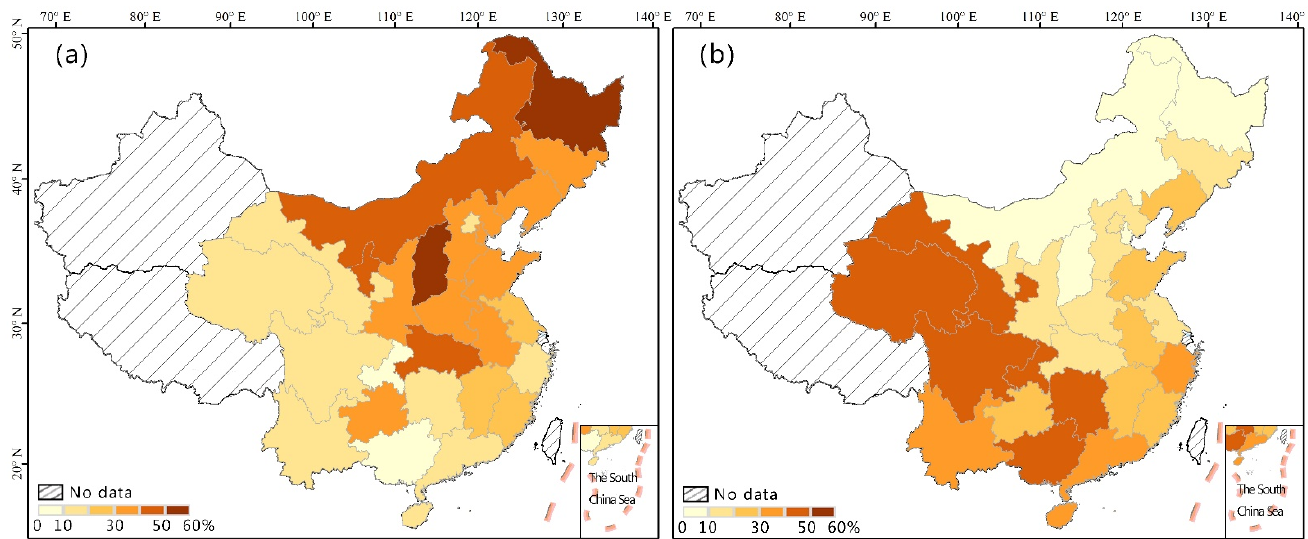
Figure 5. The current state of crop-planting selections by province in China. ( a ) Proportion of growing grain crops decisions (%); ( b ) proportion of growing cash crops decisions (%).